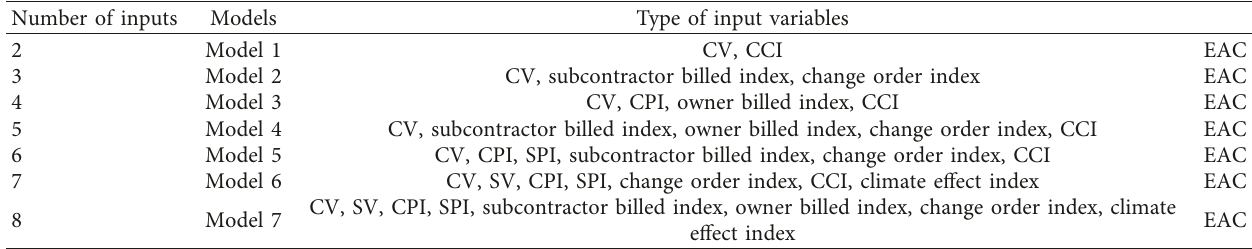
Table 7: The input combination attributes used to determine the value of the EAC using the GA-SVR